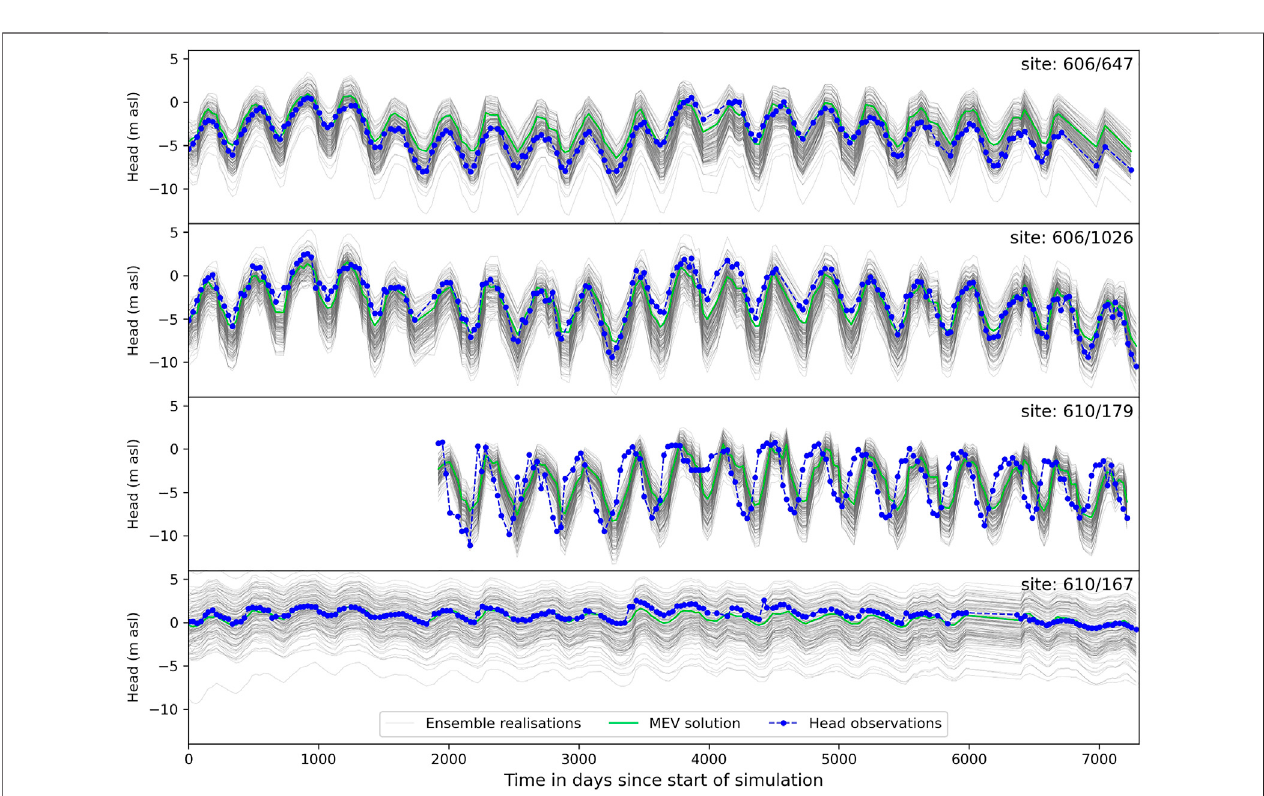
FIGURE 7 | Measured and ensemble of simulated hydraulic heads for 606/647, 606/1026 and 610/179 from the semi-con fi ned aquifer, and 610/167 from the phreatic aquifer.